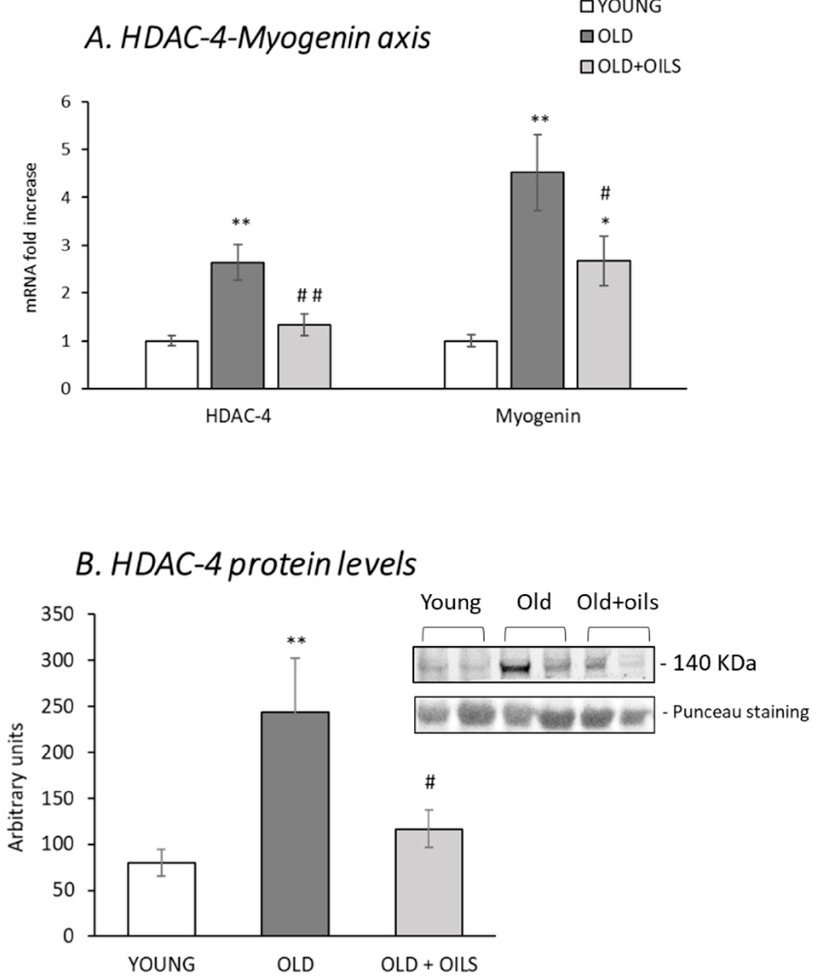
Figure 5. Oil mixture treatment prevented the age-induced activation of the HADC-4-myogenin axis in skeletal muscle. Figures show gastrocnemius mRNA levels of ( A ) histone deacetylase 4 (HDAC-4) and myogenin and ( B ) HDAC-4 protein levels of young rats ( n = 11), old rats ( n = 8) and old rats treated for 21 days with the oil mixture (OLD + OILS, n = 5). Values are represented as mean ± standard error of the mean (SEM). Statistics: ** p < 0.01 and * p < 0.05 vs. Young; ## p < 0.01 and # p < 0.05 vs. Old, by least-significant difference post hoc analysis after significant one-way analysis of variance